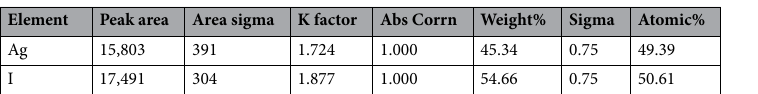
Table 3. EDS analysis of AgINC prepared using the